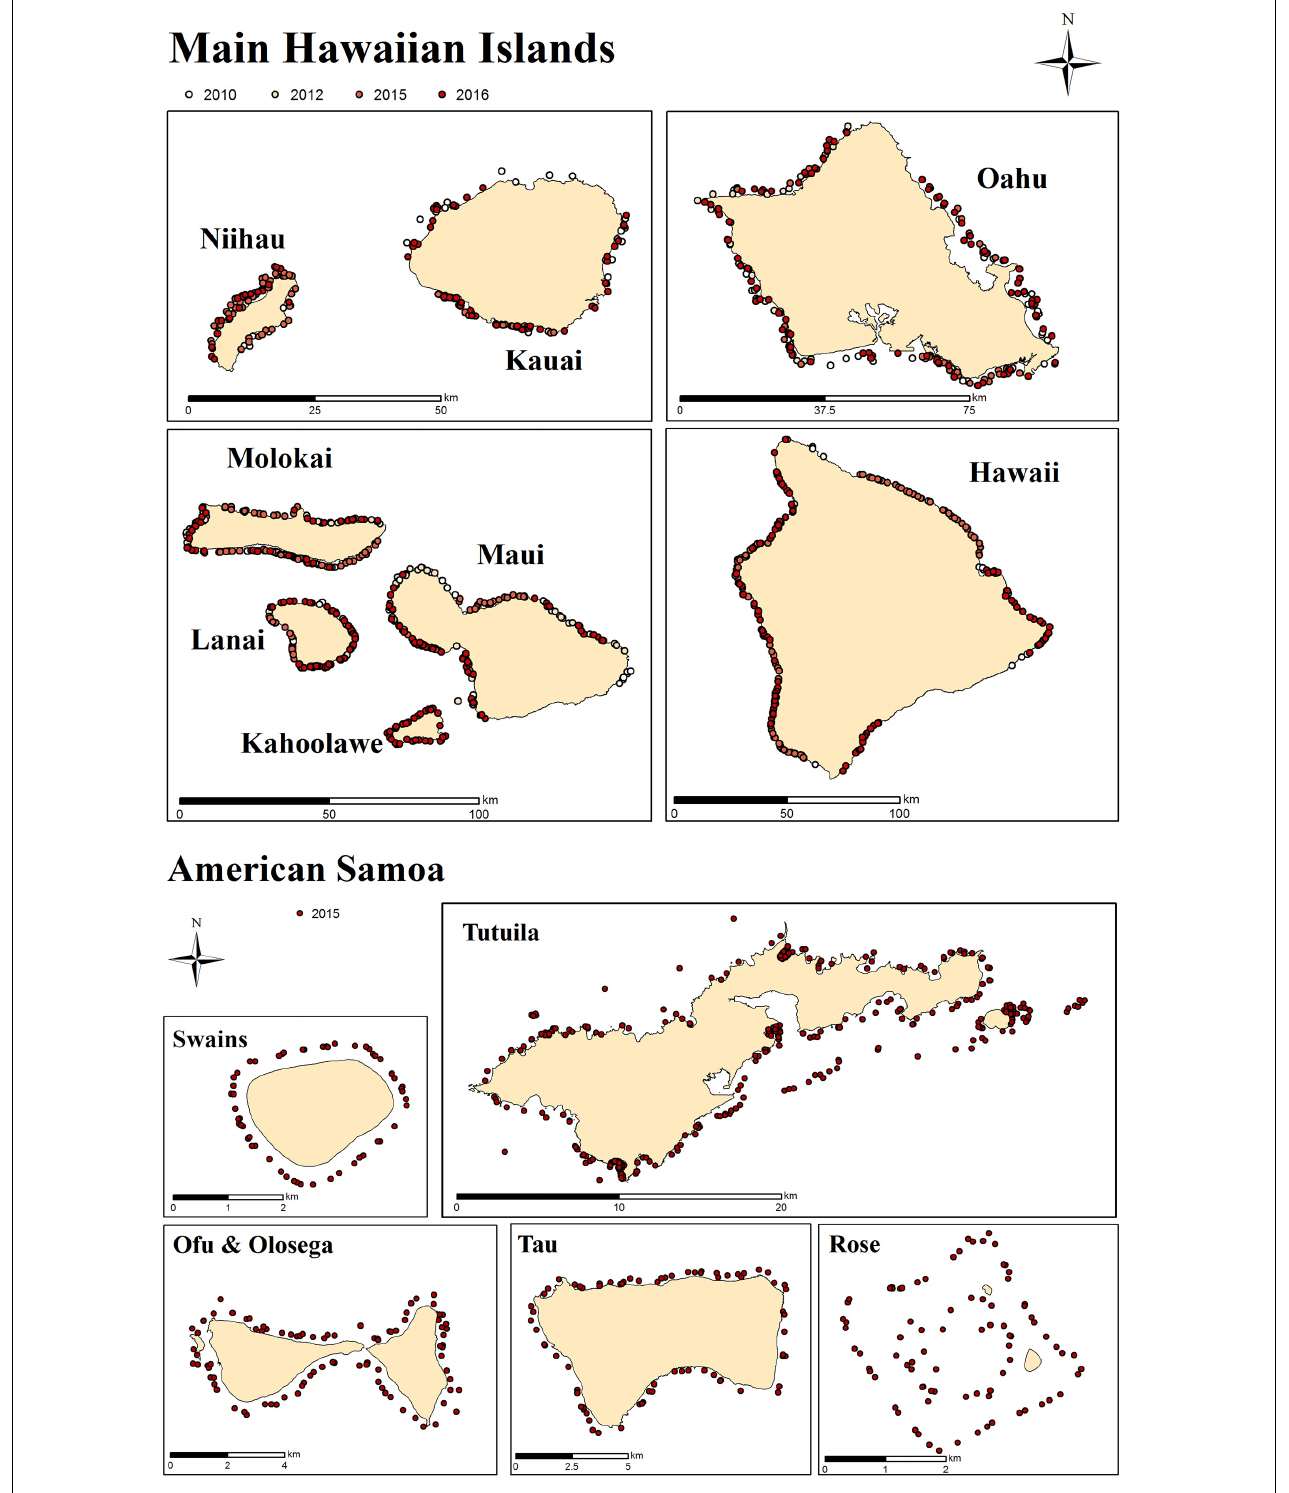
FIGURE 1 | Survey sites in MHI and American Samoa. Each dot represents a survey site. At each site, 30 planar benthic photographs were taken by survey divers from ∼ 1 m above the substrate.